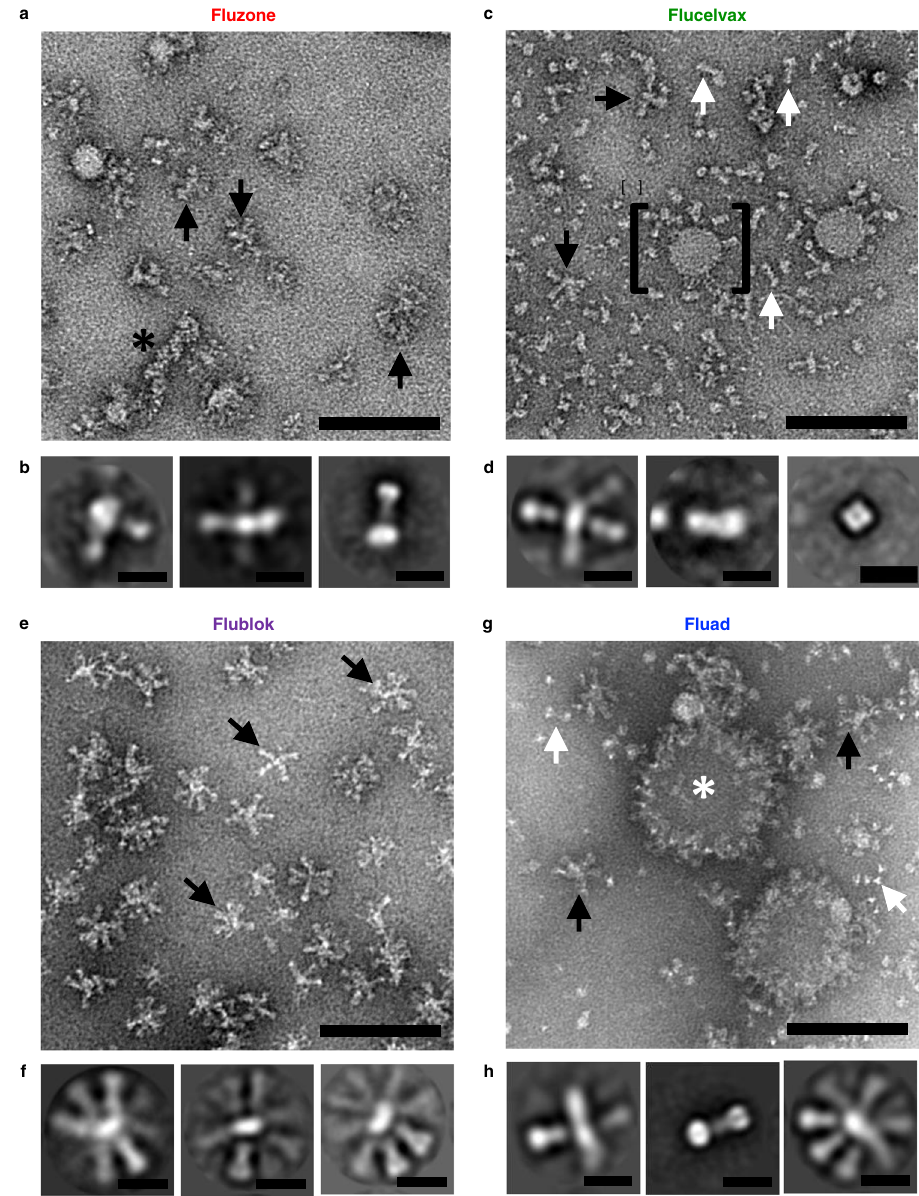
Fig. 1 | Structural organization of HA antigens in in fl uenza vaccines. a Images from negative-stain EM of Fluzone HD vaccine and b select 2D classes averages. Similarly, images and class averages for c , d Flucelvax, e , f Flublok, and g , h Fluad. Complexes observed include HA star fi sh-like complexes (black arrows), isolated molecules (white arrows), large round complexes (white asterisk), RNP (black